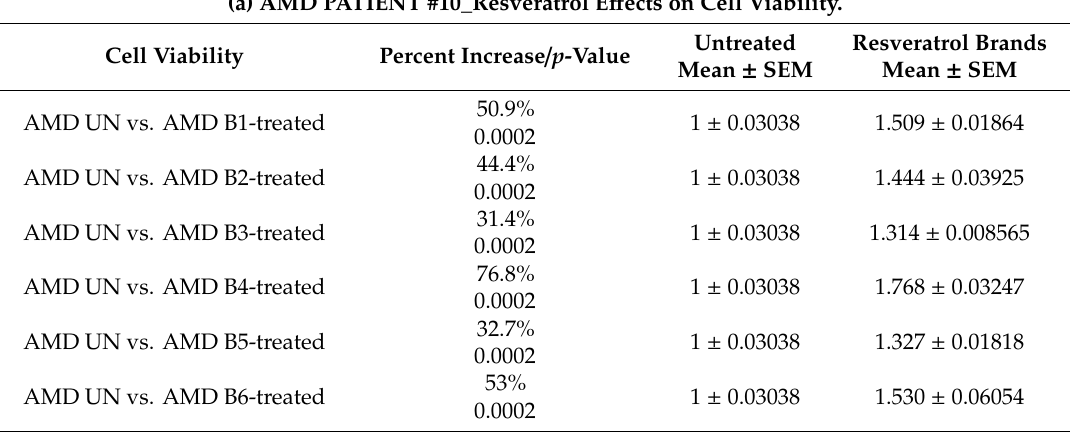
Figure 12. Effects of resveratrol formulations on cell viability ( A ) and ROS levels ( B ) in AMD patient